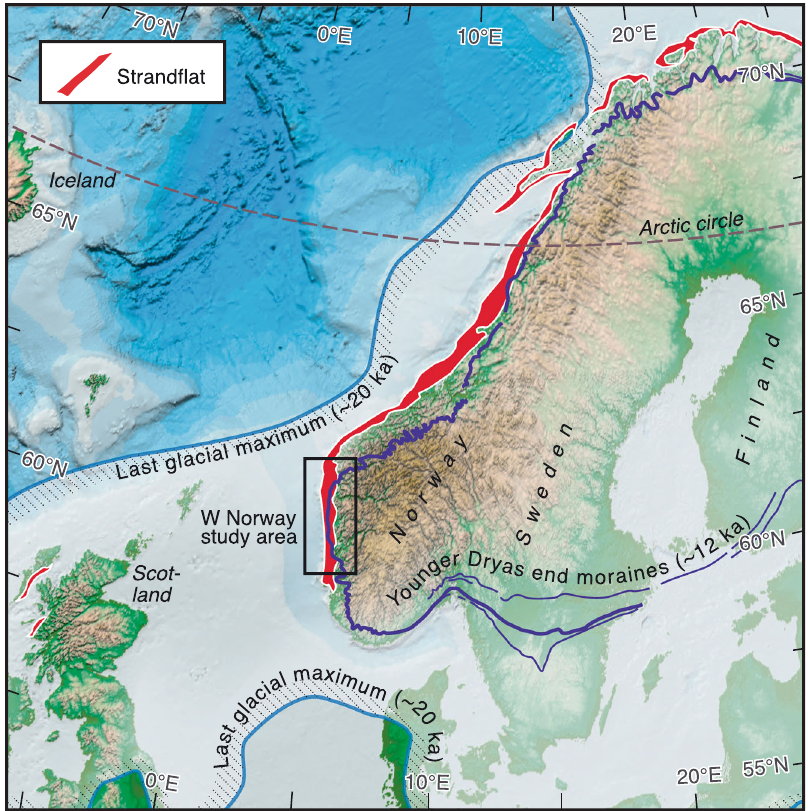
Fig. 1 Location and extent of the strand fl at in western Scandinavia. Occurrence below current sea level is included. Also shown are smaller strand fl at sections in Scotland, the last glacial maximum, and Younger Dryas end